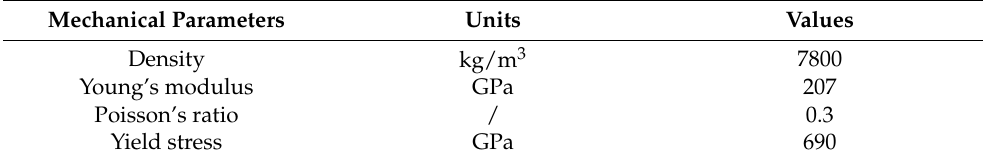
Table 1. Material property